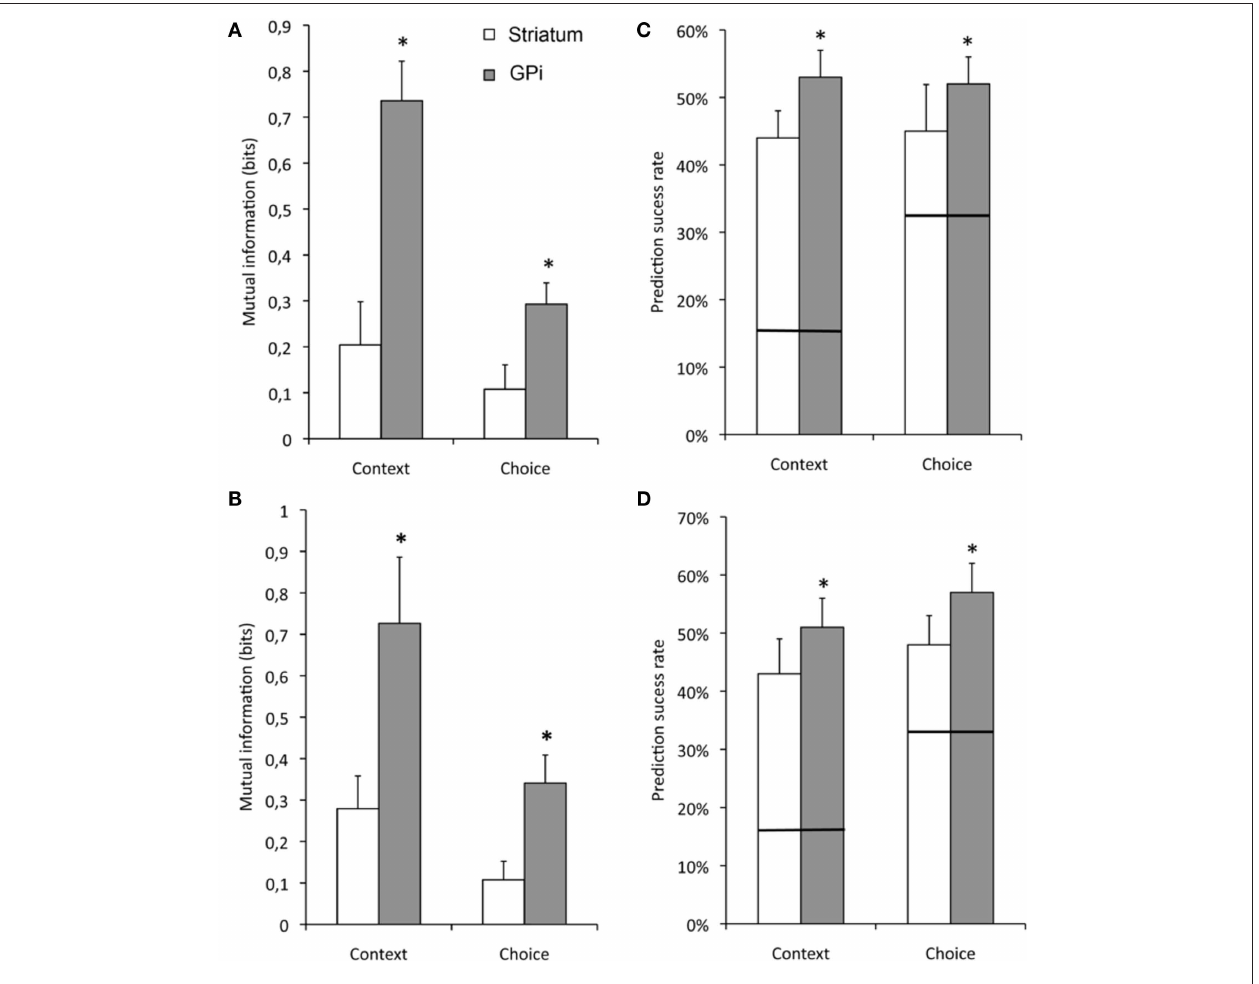
histograms indicate the respective success base chance to predict the correct values (respectively 1/6 for context and 1/3 for choice). Error bars indicate SEM (Mann–Whitney test, p